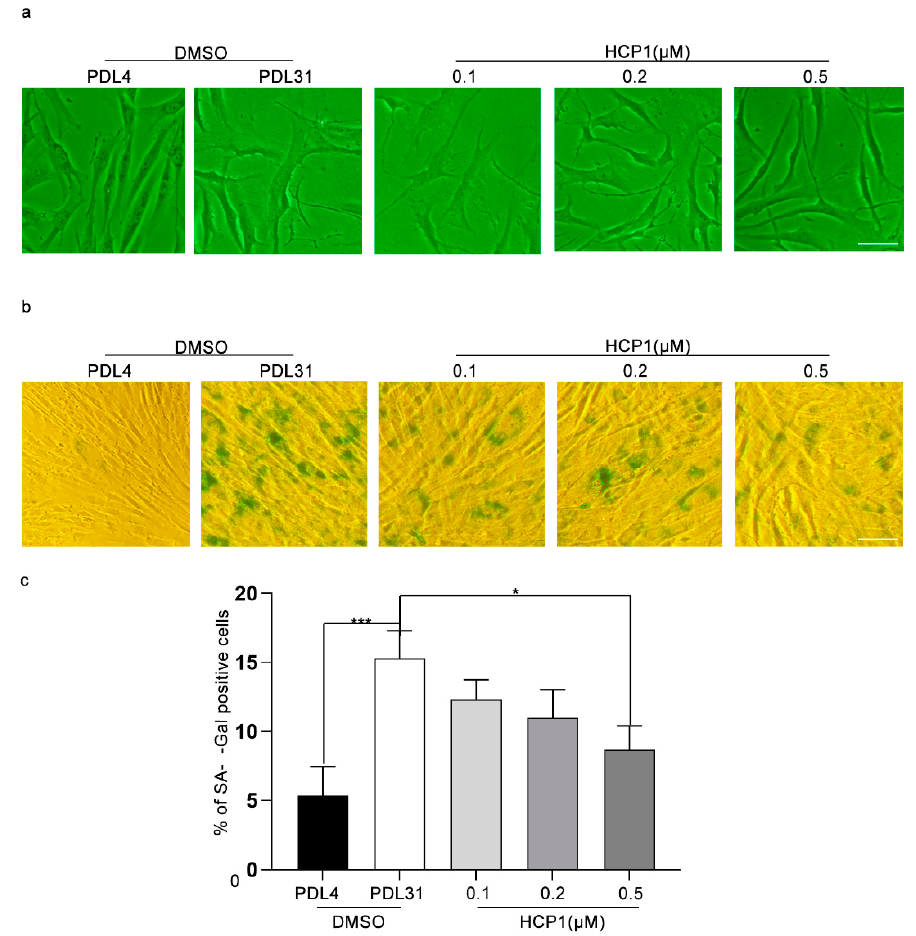
Figure 1. The effect of HCP1 on senescence HDFs. ( a ) DMSO or HCP1 (0.1, 0.2, 0.5 μ M) treated senescent HDFs (PDL = 31) for 48 h, the morphological change of senescent cells was observed by inverted phase contrast microscope (Eclipse TS-100; Nikon, Tokyo, Japan); ( b , c ) Senescent HDFs were treated with DMSO or HCP1 (0.1, 0.2 and 0.5 μ M) for 48 h. SA- β -gal was conducted to stain the senescent HDFs, and inverted phase contrast microscope was used to observed senescent HDFs. Percentage of SA- β -gal-positive cells was counted. Healthy cells (PDL = 4) as positive control. Scale bar: 100 μ m. Data are presented as means ± SEM, * p < 0.05, *** p < 0.001, n = 3.